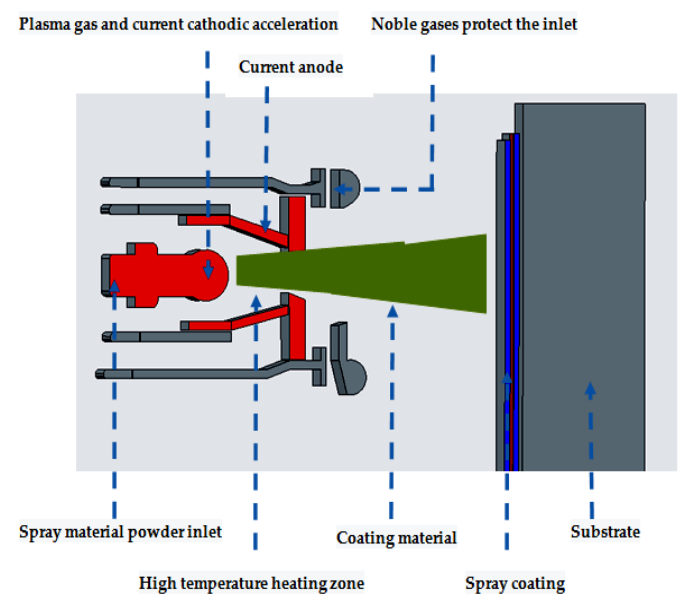
Figure 1. Schematic diagram of supersonic plasma spraying (SPS).